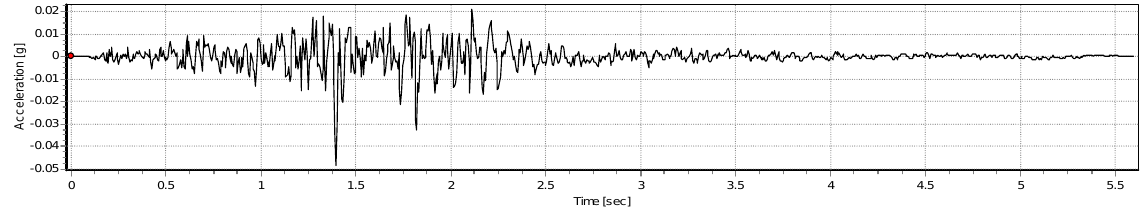
Fig. 4. Acceleration time-histories for scaled far-fault ground motion.